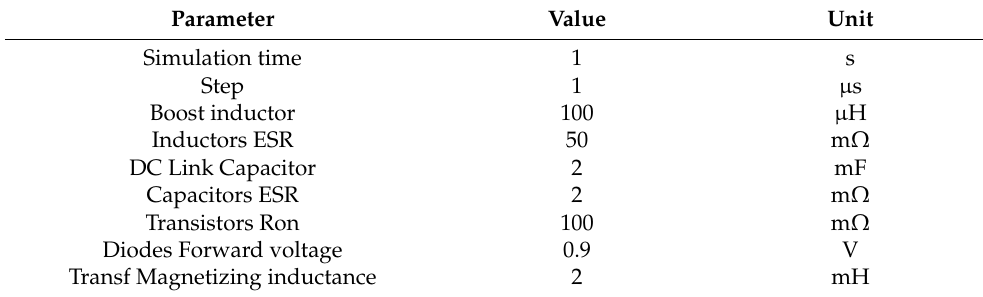
Table 2. Simulation parameters.